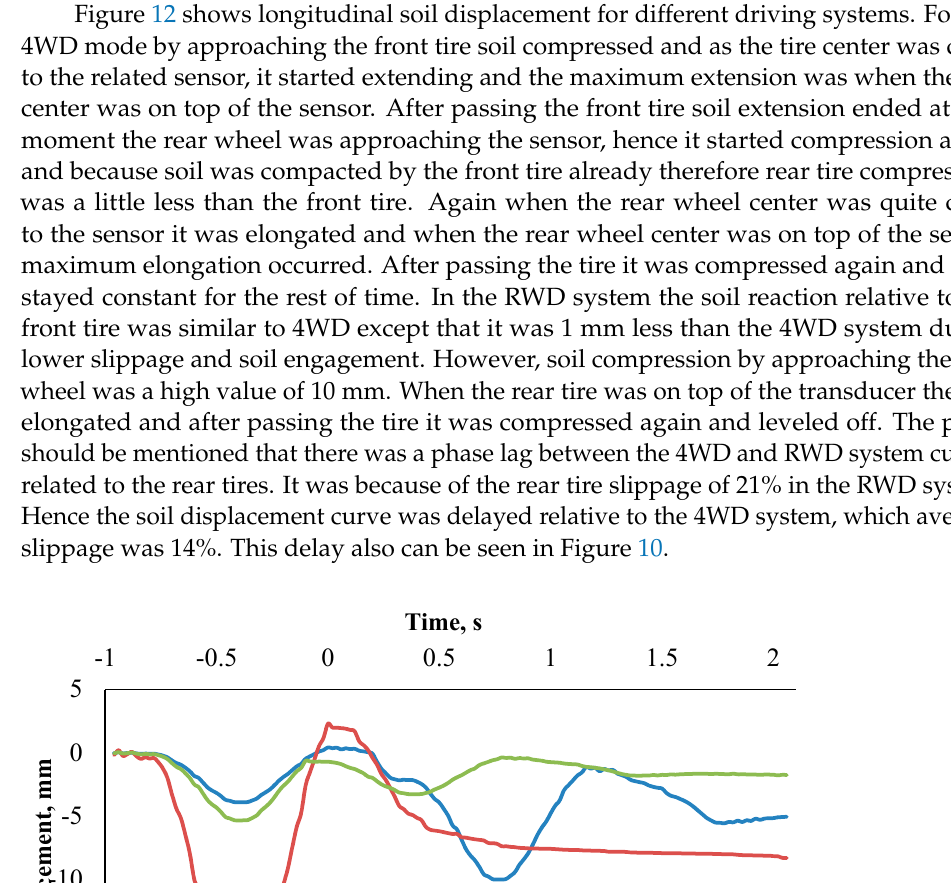
Figure 11. Soil strain along the lateral (y) direction.